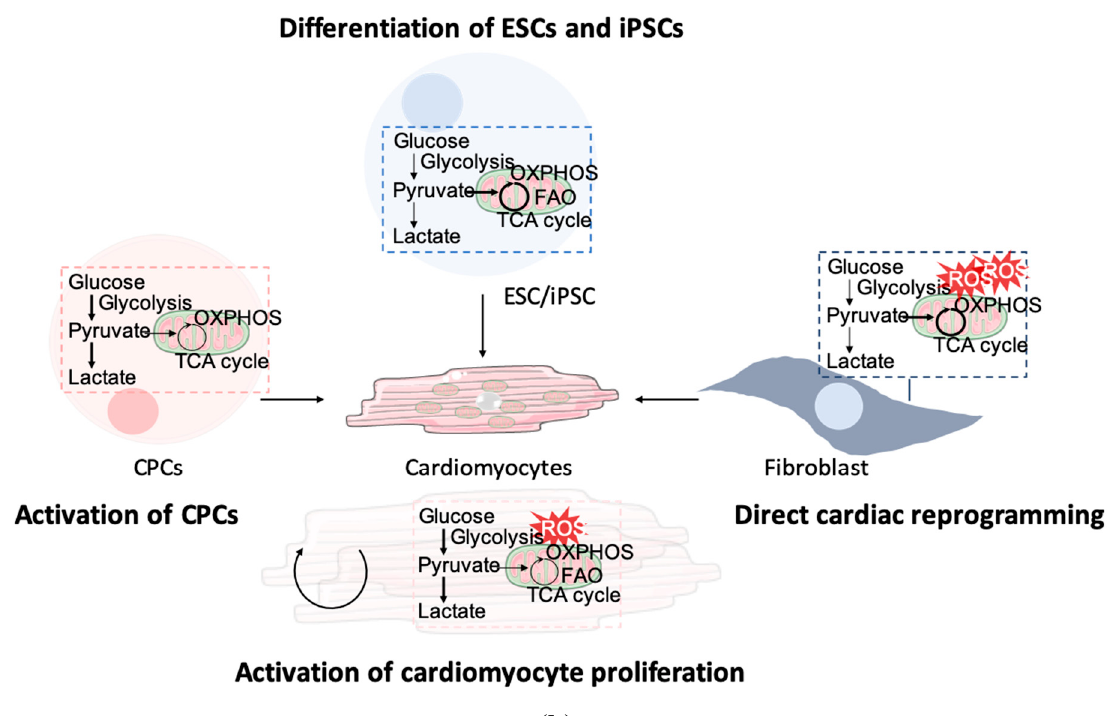
Figure 3. Heart regeneration strategies and metabolic manipulations to increase cardiac regenera- tion. ( a ) Approaches for replacing lost cardiomyocytes. By modulating factors that either promote (overexpression of cyclins) or repress (silencing of CDK inhibitors) cell cycle activity, adult cardio- myocytes, can be forced to proliferate. Metabolic and signaling pathways, as well as the expression of non-coding RNAs, can also be modulated to induce cardiomyocyte proliferation. Stimulating the differentiation of CPCs into cardiomyocytes can be achieved by treatment with TGF- β or paracrine signaling, for example. ESCs and iPSCs have been used to generate cardiomyocytes, which can be transplanted to replace cells that were lost upon cardiac injury. Direct cardiac reprogramming can be achieved by overexpressing the cardiac factors Mef2c, Gata4, and Tbx5 (termed MGT) into resi- dent fibroblasts. The addition of additional transcription factors and small molecules, and manipu- lation of miRNAs, can improve reprograming efficiency. ( b ) Metabolic reprogramming to increase cardiac regenerative potential. The stimulation of glycolysis, inhibition of FAO, and decrease in ox- ygen increase cardiomyocyte proliferation. Activation of CPCs can be induced with high concentra- tions of glucose and glutamine in the media, hypoxia, and reduction in ROS levels. Differentiation of ESCs and iPSCs into cardiomyocytes can be improved by increasing FAO, decreasing glucose, and increasing exogenous lipids and galactose. For direct cardiac reprogramming, stimulation of OXPHOS and inhibition of glycolysis increases the efficiency of the process. Abbreviations: CPCs, cardiac progenitor cells; ESCs, embryonic stem cells; FAO, fatty acid oxidation; iPSCs, induced plu- ripotent stem cells; OXPHOS, oxidative phosphorylation; ROS, reactive oxygen species; TCA, Tri- carboxylic acid cycle; up arrow: increase; low arrow: decrease.